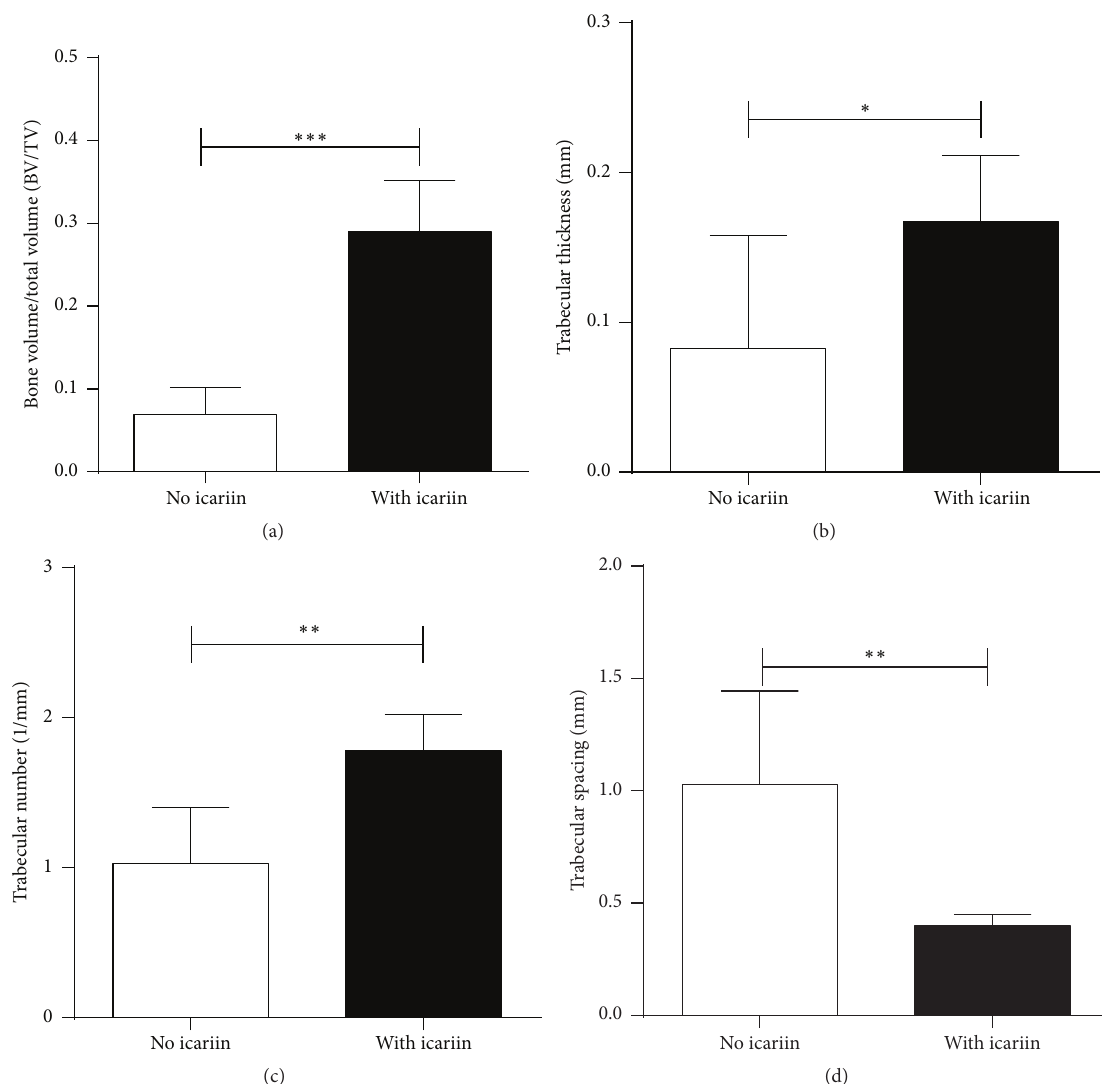
Figure 8: Graph depicting the micro-CT analysis of the BV/TV (a), Tb.N (b), Tb.Th (c), and Tb.Sp (d) of the newly formed bone within the calvarial critical-size bone defects that were treated with SMC-PHBHHx scaffolds/allogeneic BMSCs either without or with adsorbed icariin. All data are presented as mean values together with the standard deviation (SD). ∗ 𝑝 < 0.05 ; ∗∗ 𝑝 < 0.01 ; ∗∗∗ 𝑝 < 0.001